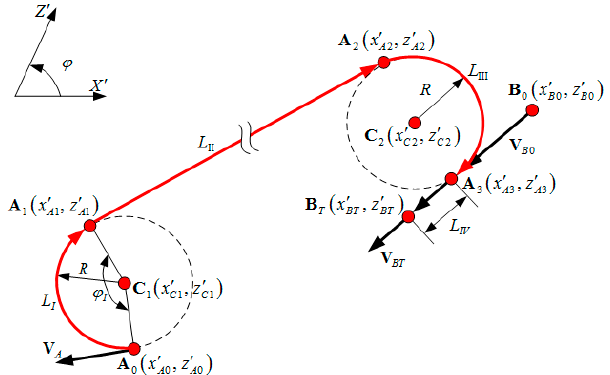
Figure 2. Characteristic approach trajectory of an UAV and a vessel.